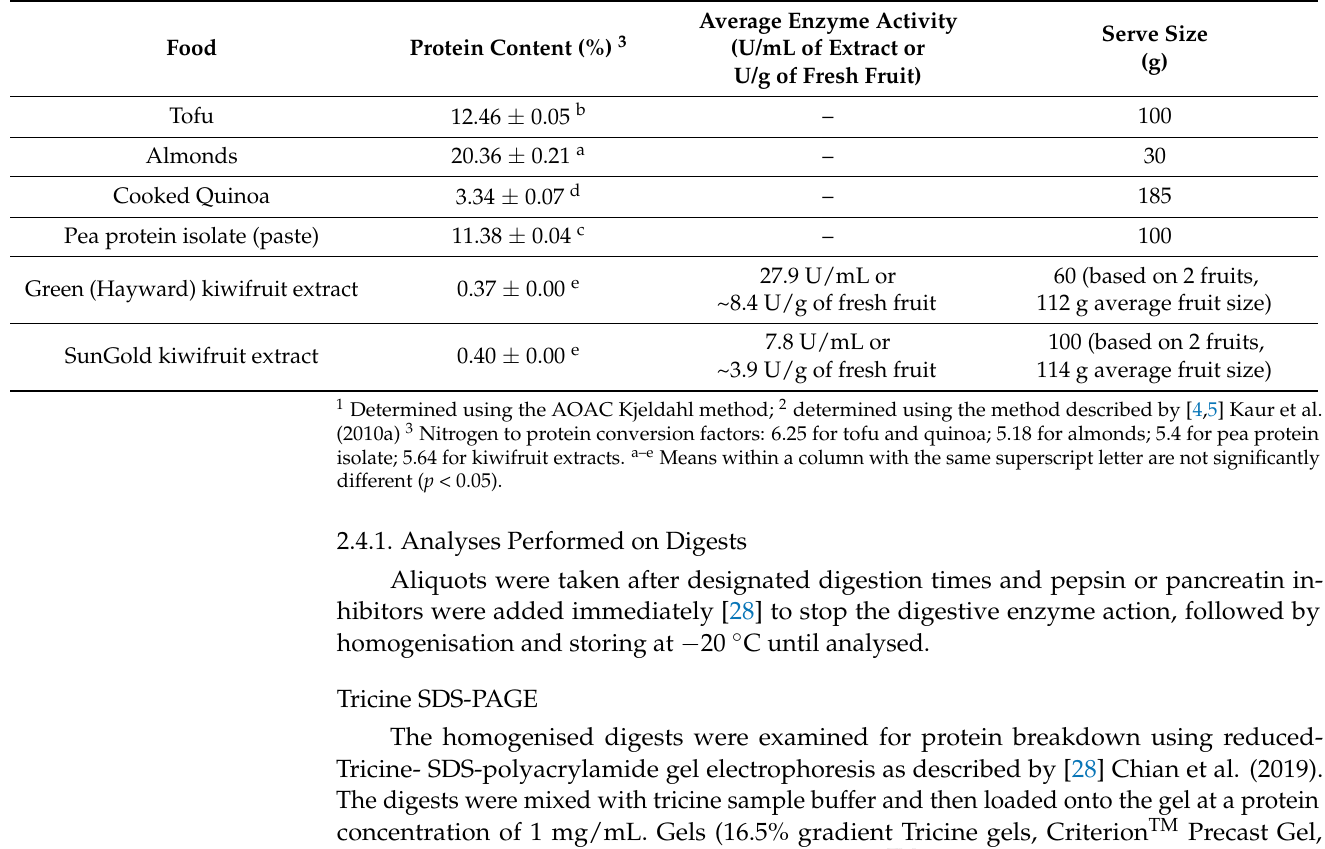
Table 1. Nitrogen, crude protein contents 1 of foods; kiwifruit extract enzyme activities 2 and other